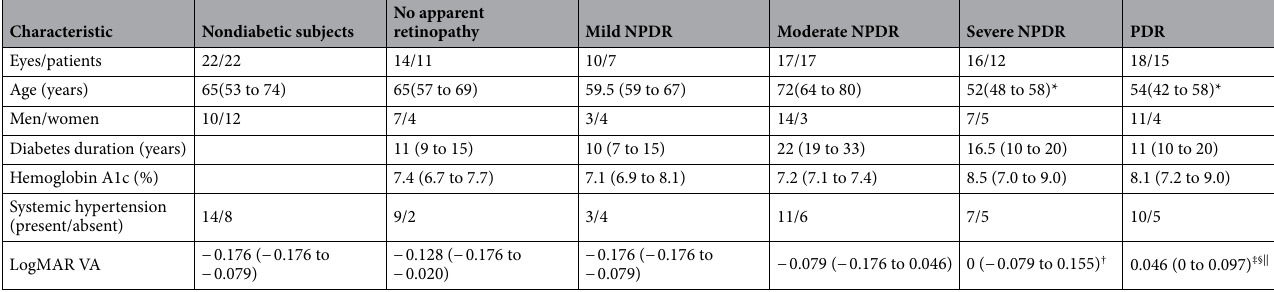
Table 1. Characteristics of the patients. * P < 0.01 versus moderate NPDR. † P < 0.01 versus nondiabetic